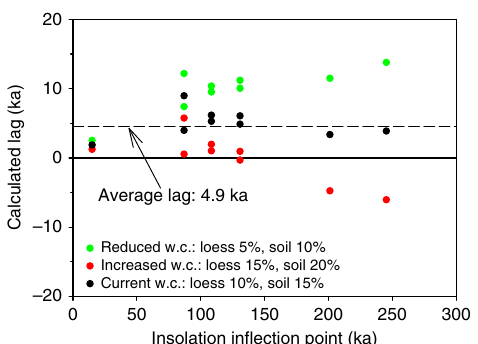
Fig. 9 Insolation lag as a function of insolation in fl ection point time for different water content assumptions. Dashed line is drawn at the average of the insolation lag data given in Supplementary Table 2 (black symbols) and shown in Fig. 4. Solid line indicates but positive trend in the size of the lag is observed when the water content is decreased by 5% (green symbols in Fig. 9). In summary, changing the water content by ±5% introduces trends in the lag with time and increases the standard deviation of the lags from the original ~2 ka (Supplementary Table 2) to ~3 ka. We conclude that our current water content assumption remains the most likely. It does not produce any systematic trend in the insolation lag with time and, if anything, the uncertainty on the water content has been overestimated.